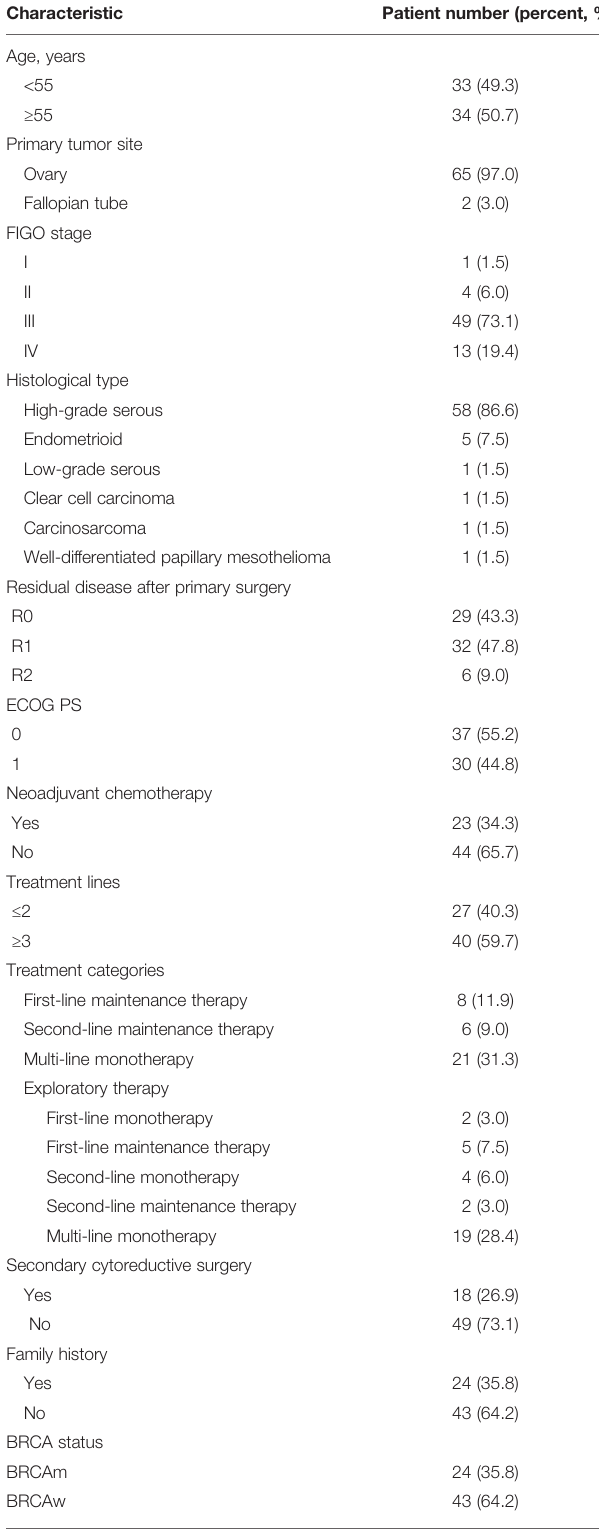
TABLE 1 | Baseline characteristics of patients with HRD test. Values are reported as frequency (n [%]) or as mean (range).